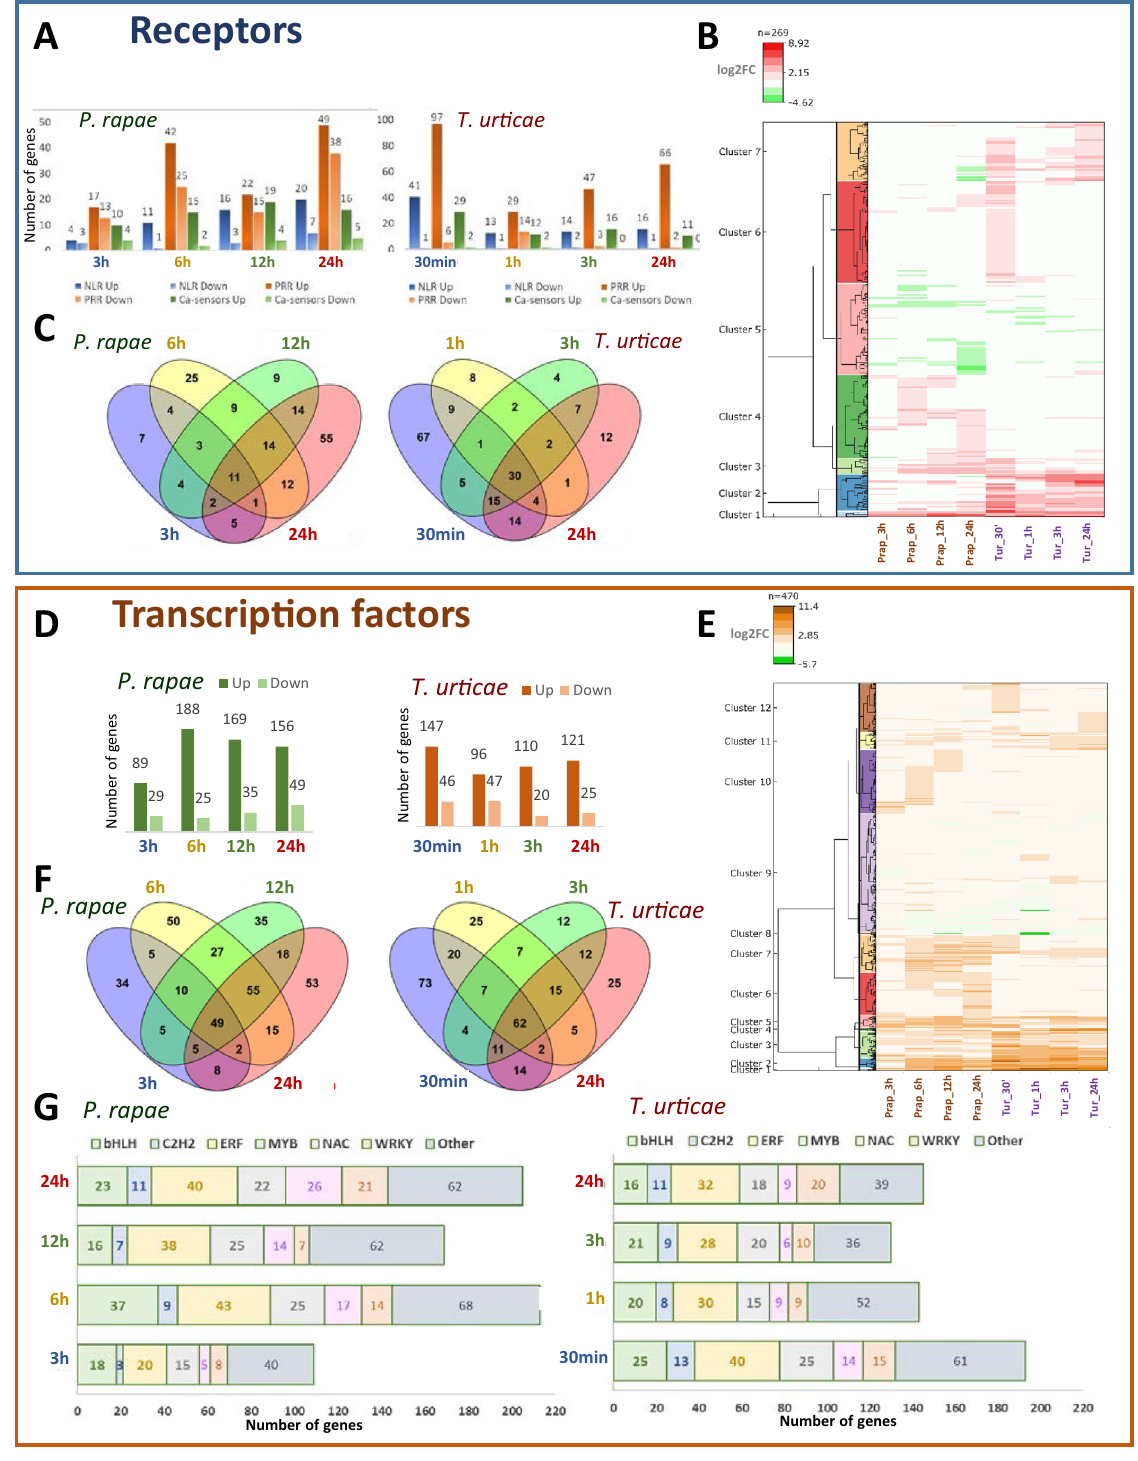
Figure 3. Comparison of the transcriptomics data for putative receptors and TFs at four time points of infestation by P. rapae or T. urticae . ( A ) Bars diagrams showing the number of up- or down-regulated receptors at each infestation time point. ( B ) Heatmap showing the transcriptomic profile of the differentially expressed receptors detected at least in one experiment. ( C ) Venn diagrams showing the number of specific and shared regulated receptors among infestation time points. ( D ) Bars diagrams showing the number of up- or down-regulated TFs at each infestation time point. ( E ) Heatmaps showing the transcriptomic profile of the differentially expressed TFs detected at least in one experiment. ( F ) Venn diagrams showing the number of specific and shared regulated TFs among infestation time points. ( G ) Bars diagrams showing the number of regulated TFs from the most relevant categories at each infestation time